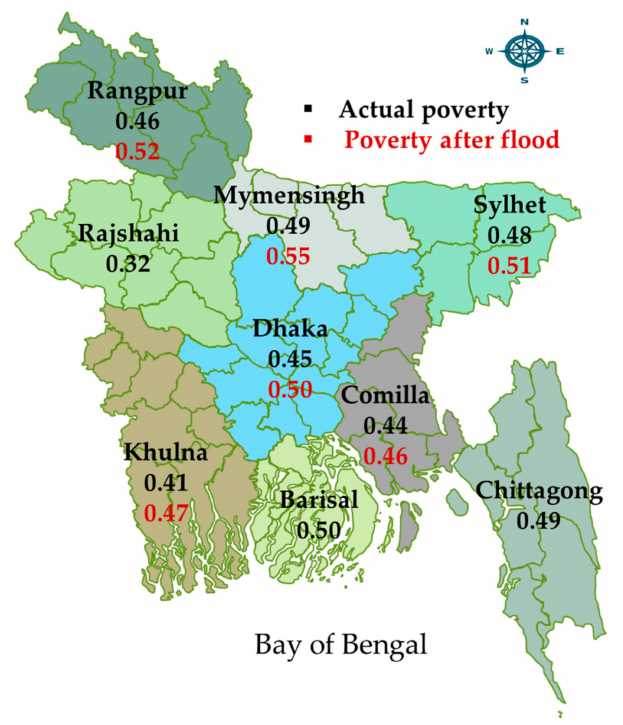
Figure 14. Changing poverty rates caused by floods in different